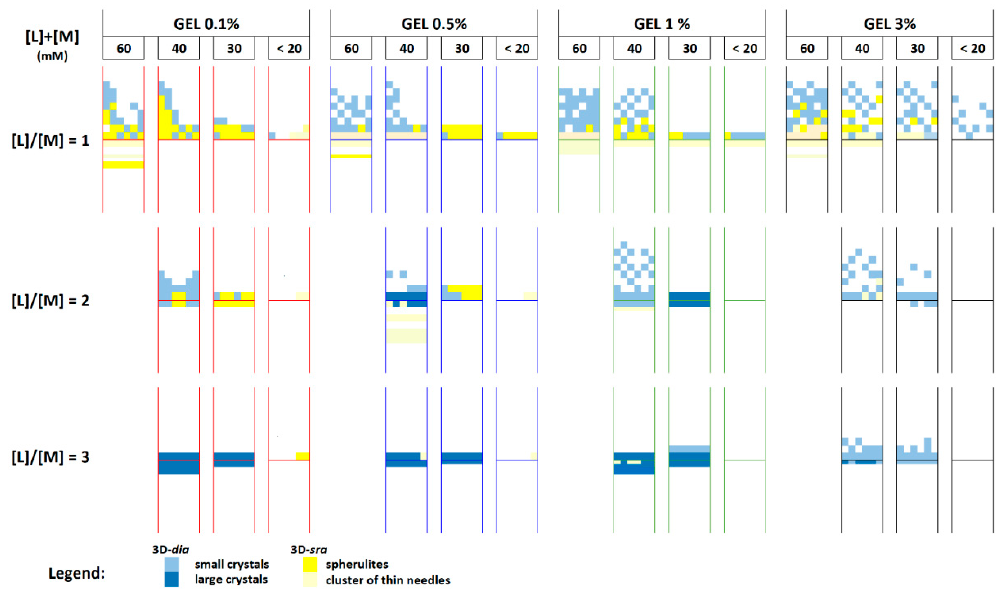
Figure 3. Summary of results of the crystallization screening performed by using the two layers-gel technique (in water-ethanol) for CdCl 2 -bpp. The stability regions of the different species are shown as a function of [L] + [M], [L]/[M] and gel strength parameters (M = Cd 2+ ; L = bpp). The phase distribution along the tube is also shown.